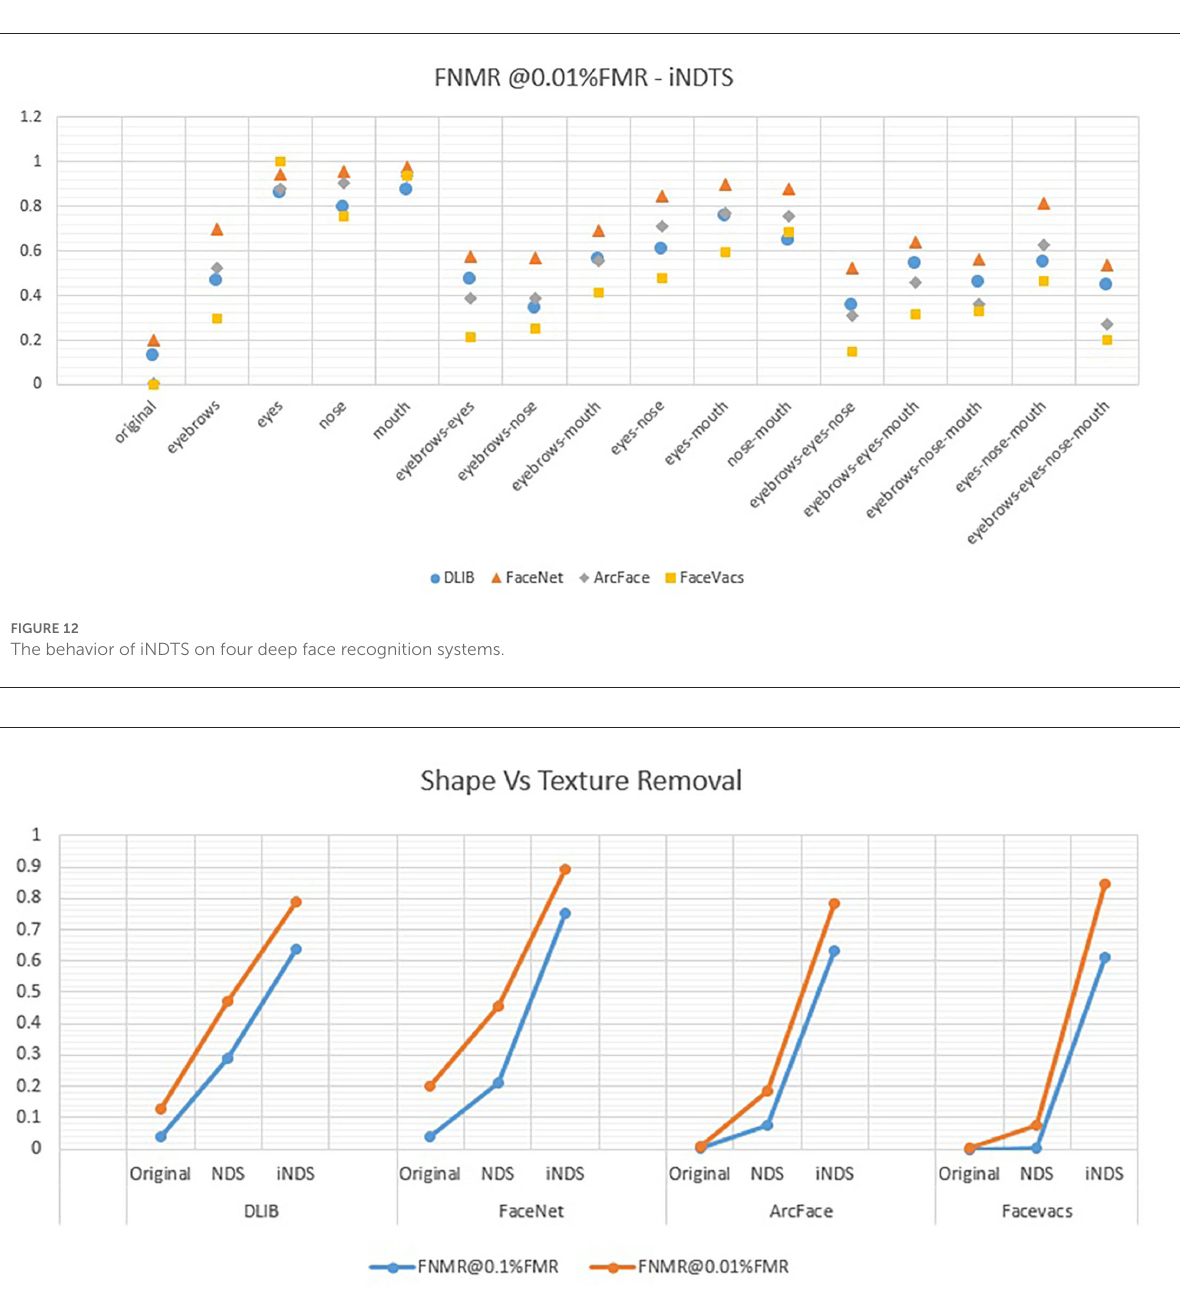
FIGURE13 The response of FRs to NDS and